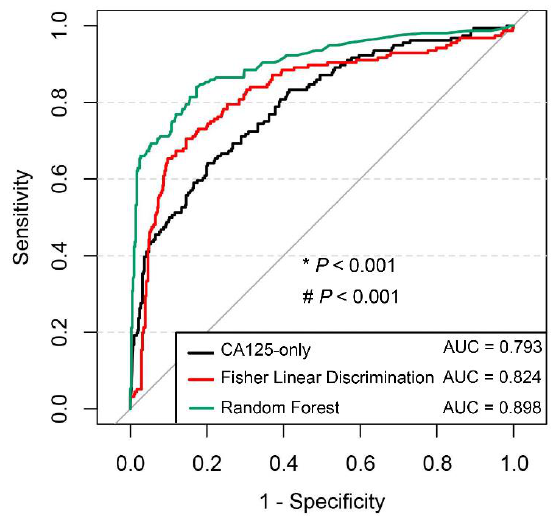
Figure 4. Receiver operating characteristic (ROC) curves of the preferred linear versus nonlinear models for the diagnosis of ovarian cancer. Note: * Area under the ROC curve (AUC) of random forest compared with AUC of Fisher’s linear discriminant model; # AUC of random forest compared with AUC of CA125-only.